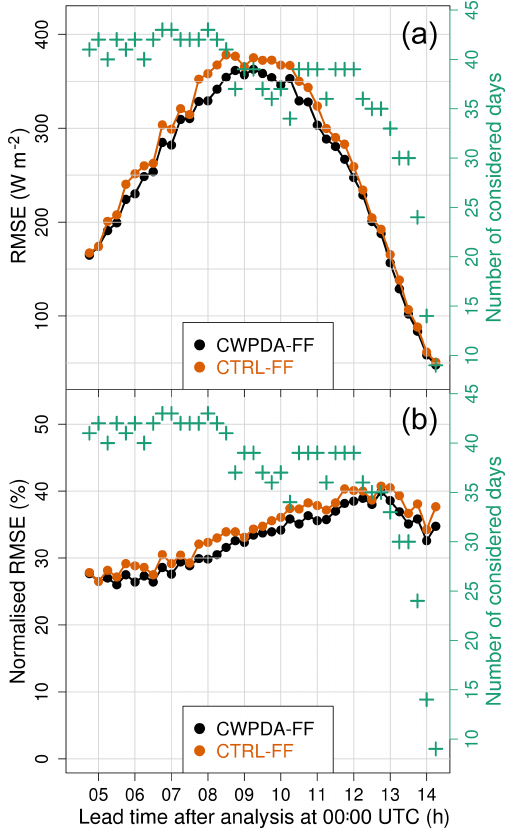
Figure 10. Absolute (a) and clear-sky normalised (b) RMSE of the WRF irradiance forecasts per lead time as a mean over the 12 con- sidered sites on Réunion Island for all free forecast dates listed in Table 1 (44 in total). Values for the two experiments CWPDA-FF (black) and CTRL-FF (orange) are shown. The number of consid- ered days per lead time (green crosses) varies since a given lead time of a given day is considered only when observations are available for all 12 sites. Local time is UTC −